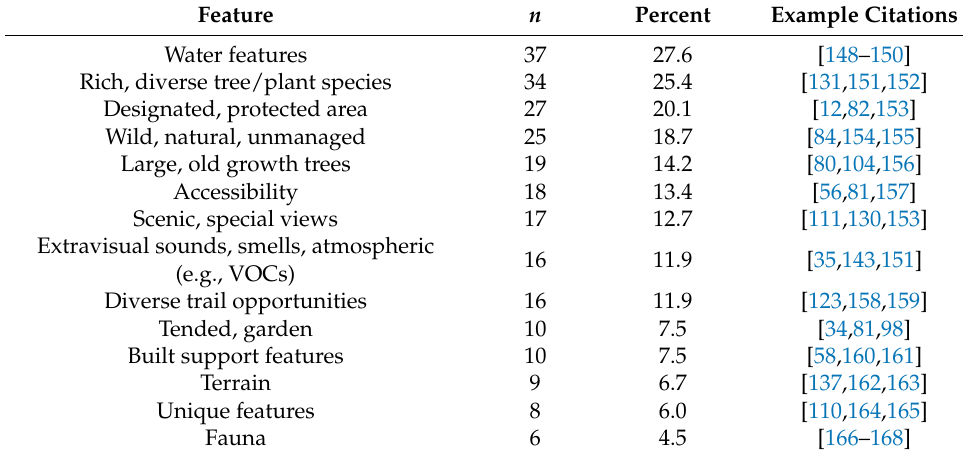
Table 4. Notablefeaturesmentionedinforestsettingdescriptionsinthearticleset( n